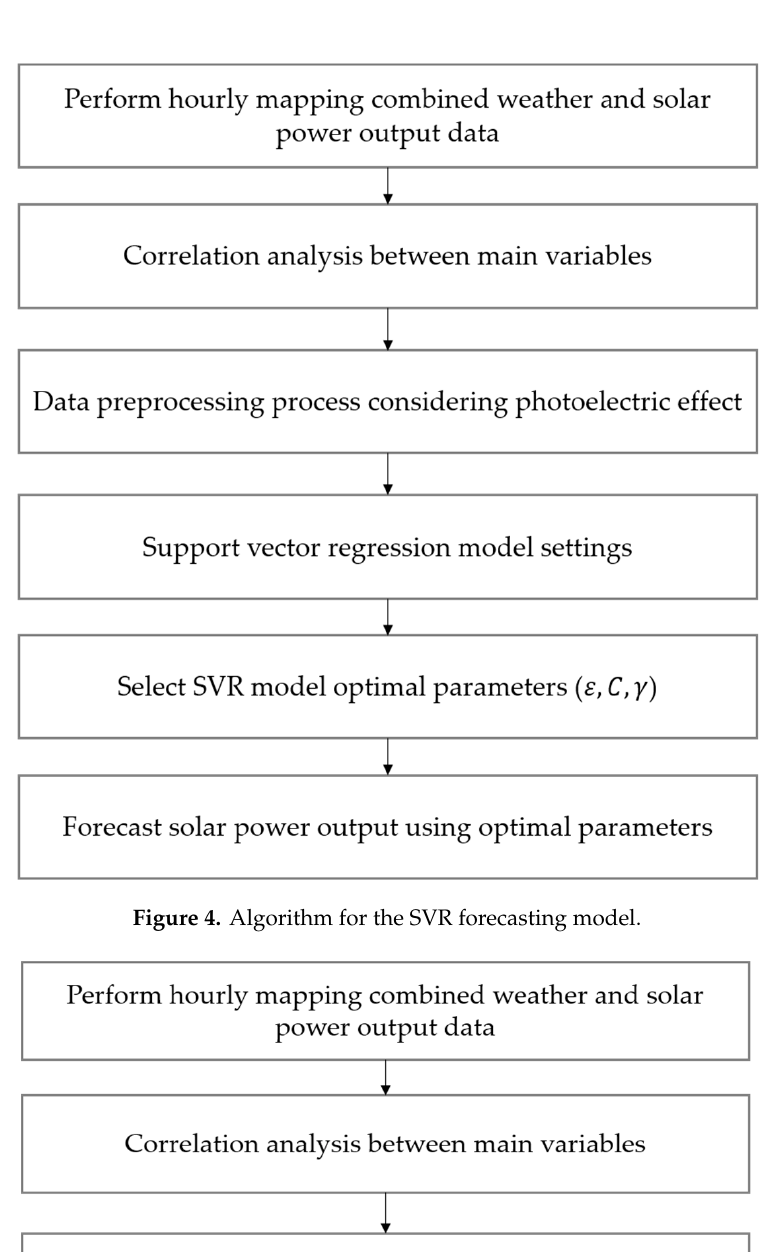
Figure 3. Algorithm for the NBC forecasting model.